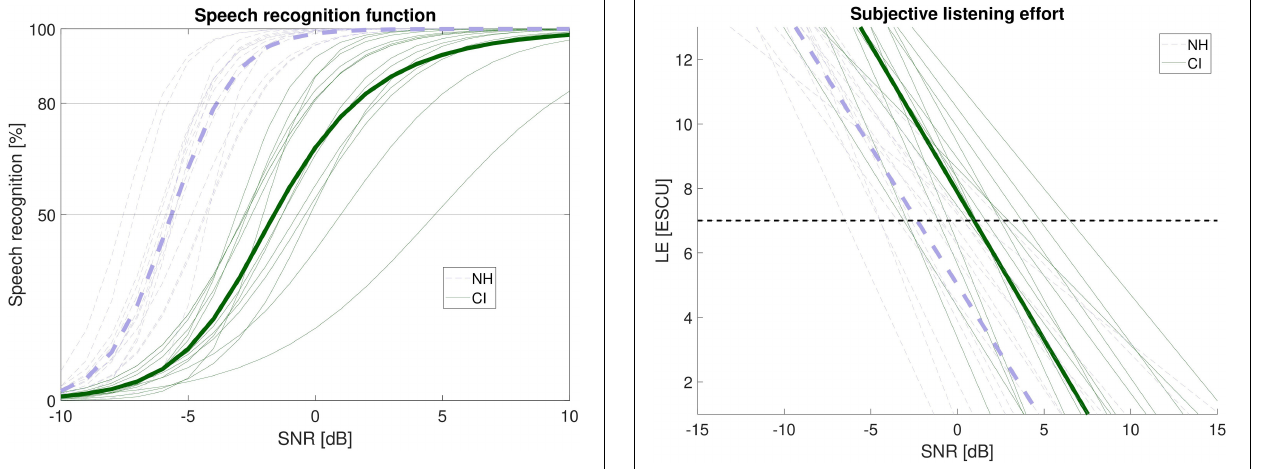
FIGURE 2 | Listening effort (LE) assessed by ACALES as a function of the signal-to-noise ratio (SNR) in CI recipients (green) and NH listeners (violet). Bold lines represent the mean. ESCU = Effort Scaling Category Units. The dashed horizontal line shows the value of 7 ESCU (“moderate effort”).